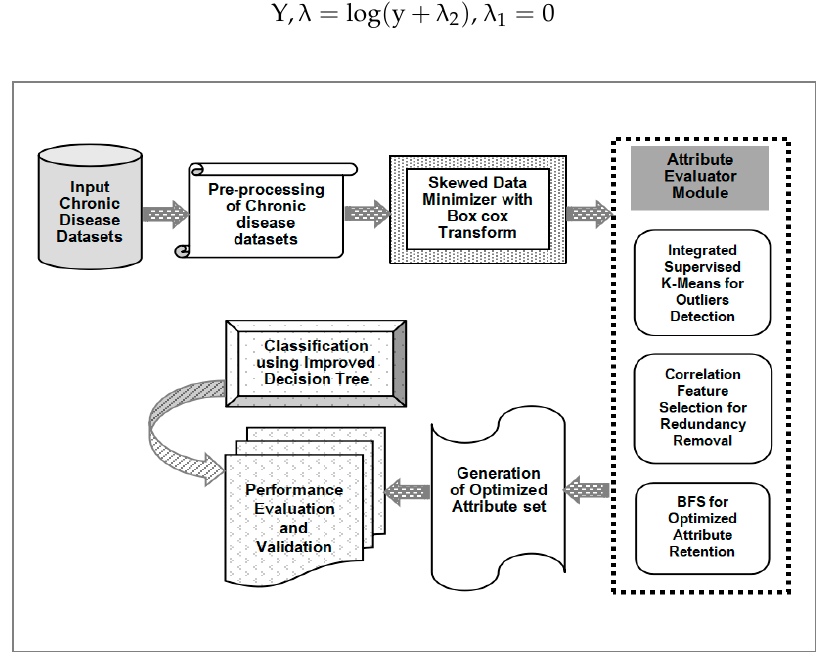
Figure 12. Illustration of the Hybrid Classification Model based on 3-Step Attribute Evaluator.